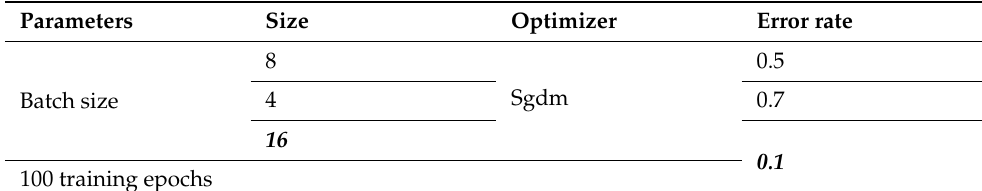
Table 1. Proposed model training